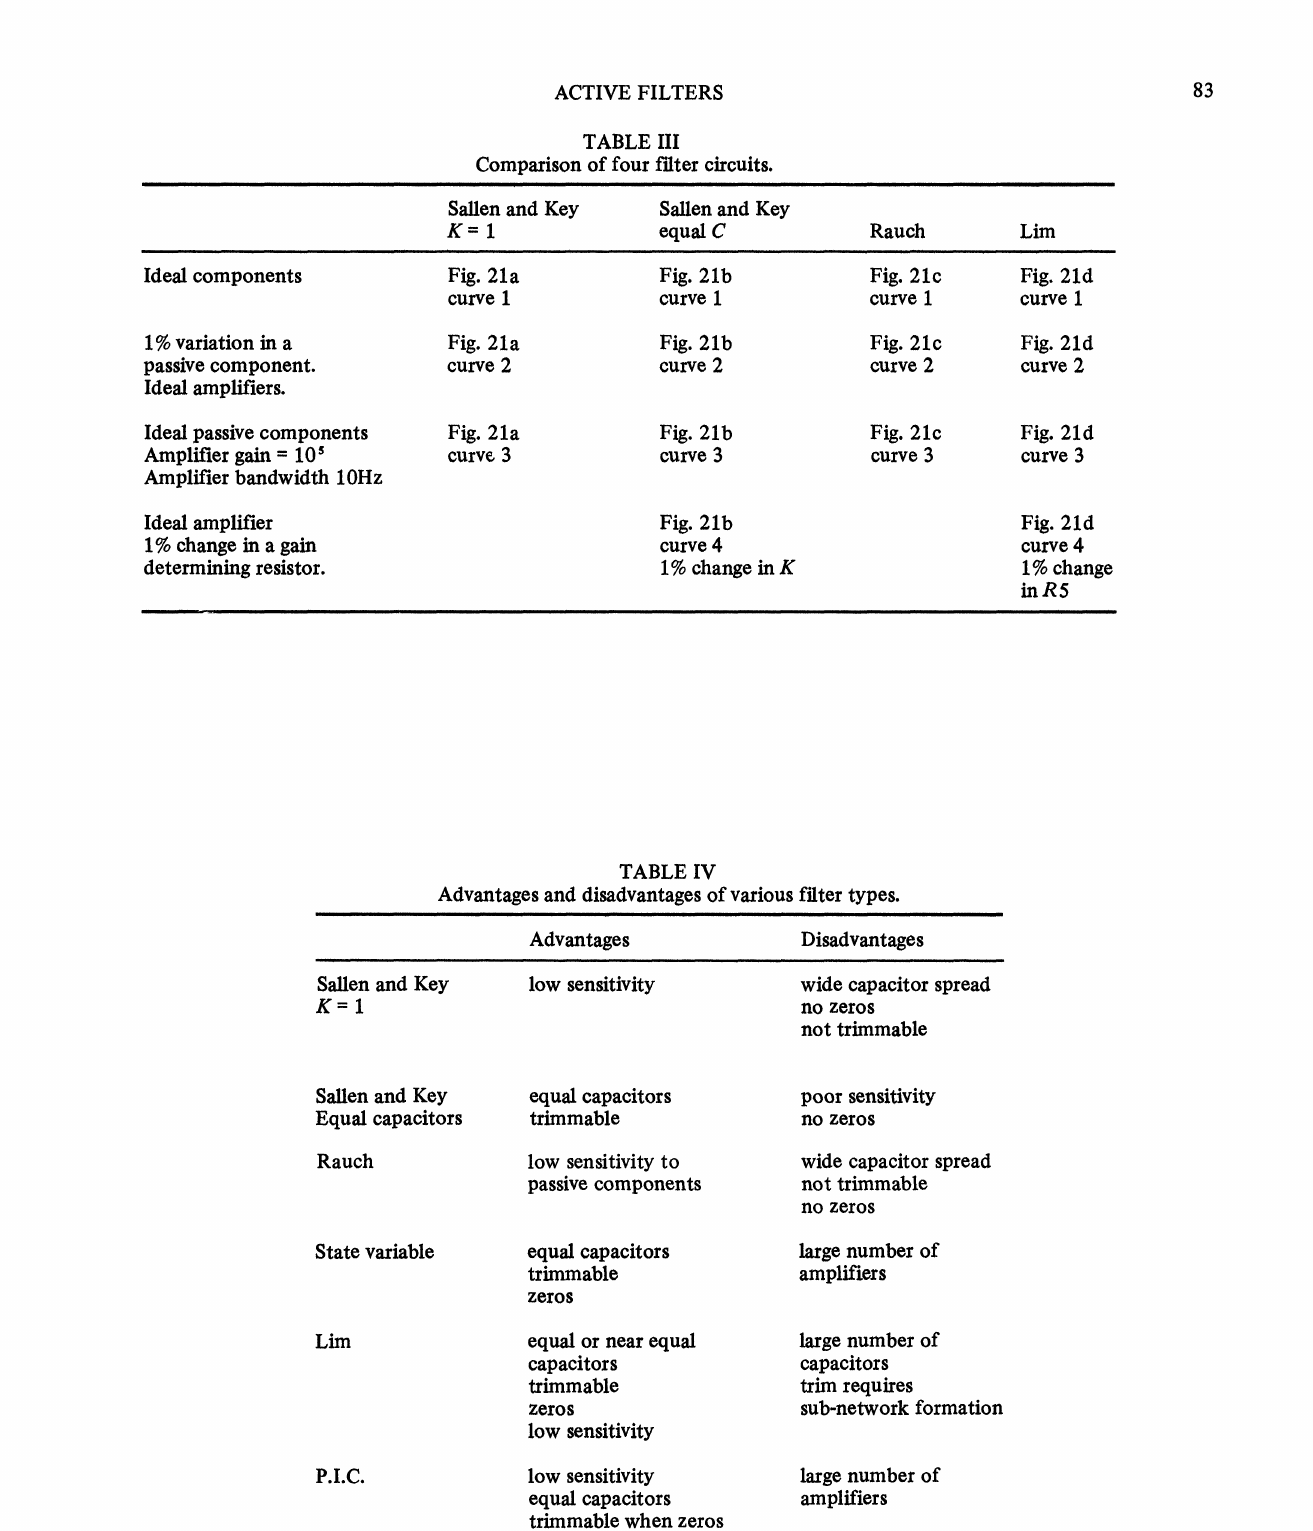
TABLE IV Advantages and disadvantages of various filter